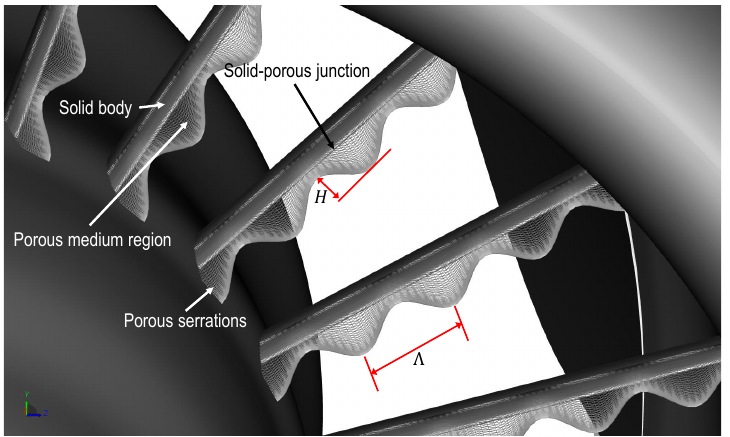
Figure 2. A closer view of the modified OGV (M800/M450 configurations) in the fan stage, highlight- ing the amplitude H and wavelength Λ of the serration